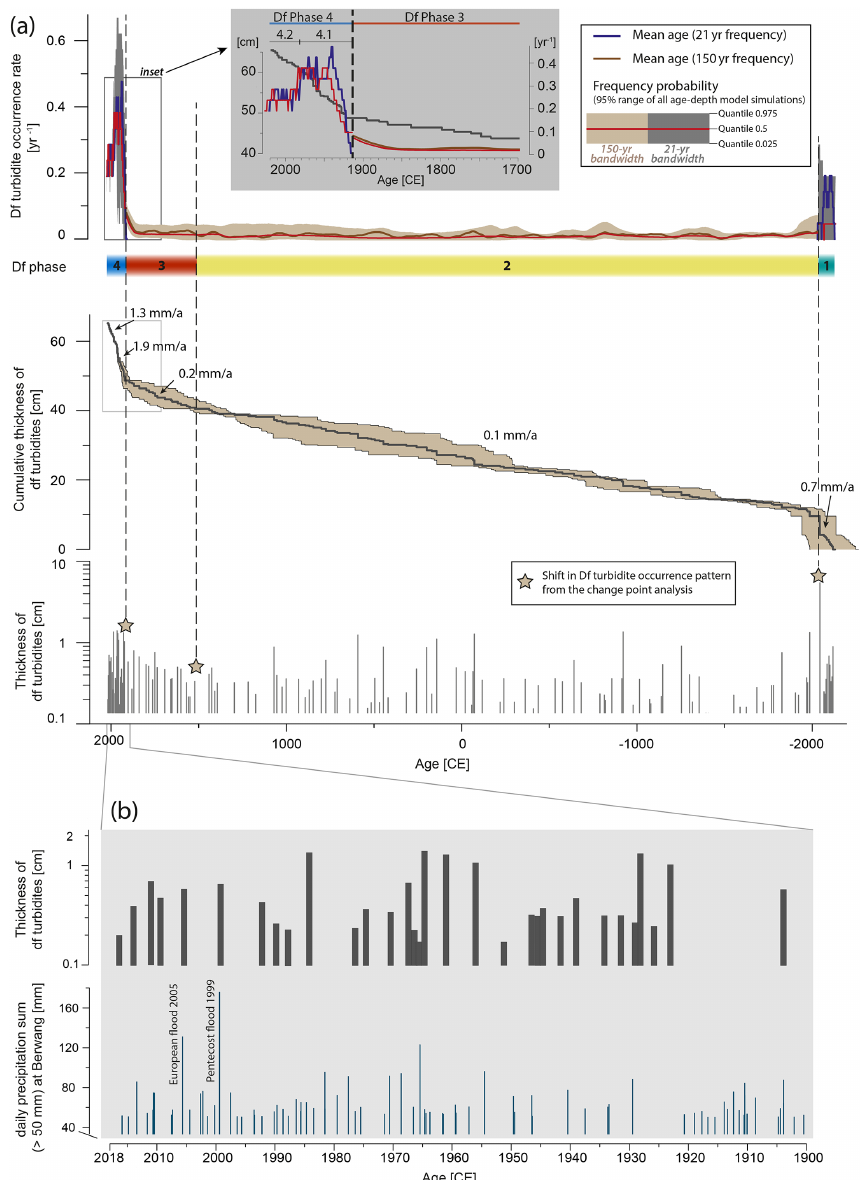
Figure 8. Temporal distribution of debris-flow-induced (df) turbidites in the distal core Plan 18-10. (a) The temporal and thickness distri- bution of the 138 df turbidites is displayed based on their mean age (bottom). The cumulative thickness of the df turbidites over time, given the mean event ages (black line), and their modelled 95% probability range (light brown area) are shown in the central panel. In the top panel, the annual occurrence rate of df turbidites is displayed as the annual frequency of the mean age (21- and 150-year bandwidth) and the 95% frequency probability is bracketed by the 0.025 and 0.975 quantiles of all 6396 individual age–depth model simulations (150-year bandwidth – light brown; 21-year bandwidth – grey). Note that the 21- and 150-year bandwidth frequencies are only valid for certain periods defined by a bandwidth selection test and are over-/undersampled for other periods. A comparison of the frequency probabilities from the two bandwidths is provided in Fig. S3. The four df phases (phases of similar debris flow activity derived from a change point analysis of interevent times) are delimited by vertical dashed lines across these three plots. The grey shaded inset in the top panel shows a magnified view of the cumulative thickness and 21- and 150-year frequency of debris flows in the period 1700–2018CE. Note the good fit of the yearly df turbidite frequency from the 0.5 quantile with the mean age from the 21-year bandwidth in the last century. Phase 4 is subdivided, based on the frequency changes, into a high-frequency phase 4.1 and a phase 4.2, with a lower, but still 7 times higher, frequency than phase 3. (b) Comparison of df turbidite thickness since 1900CE, with daily precipitation sums ( > 50mm) at the weather station of Berwang, which is 7km away (eHYD, 2020), highlighting the potential temporal coincidence of the strongest flood events in 1999 and 2005CE with df tur- bidites. Mean age uncertainties are ± 6 years (2018–1960CE) and ± 19 years (1959–1920CE; see also Table S4). Note that rainfall intensity and thickness distribution do not correlate, and not every year with high daily precipitation ( > 50mm) has a corresponding df turbidite and vice